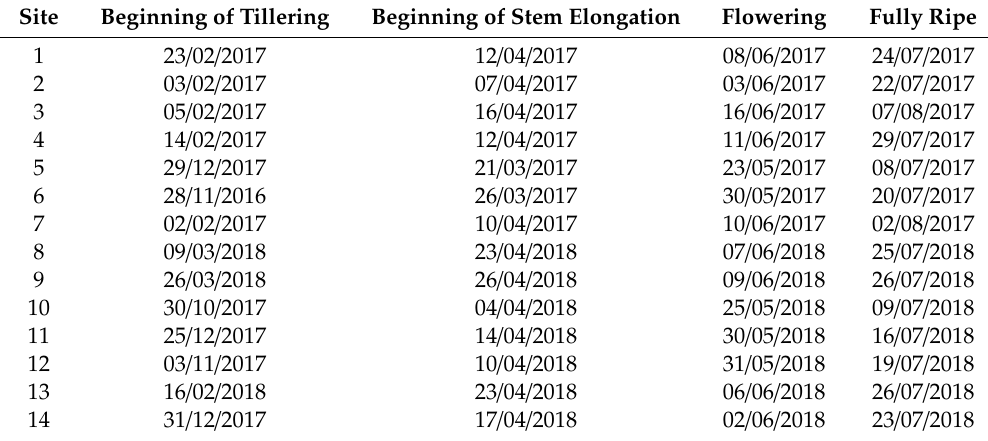
Table A2. Dates of winter wheat growth stages in the study sites as estimated by the xarvio TM growth stage model. The following growth stages are provided: beginning of tillering (BBCH 21 = DVS 0.2), beginning of stem elongation (BBCH 30 = DVS 0.5), flowering (BBCH 65 = DVS 1.0), fully ripe (BBCH 89 = DVS 2.0). Dates provided as DD / MM /